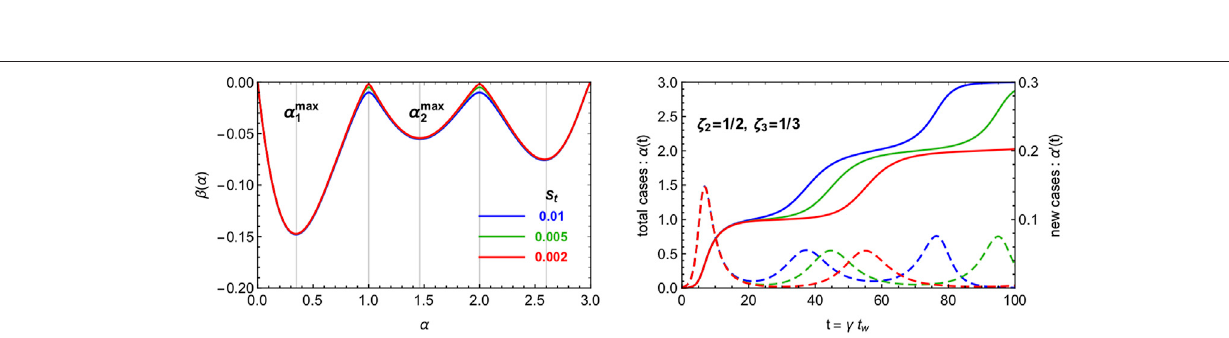
FIGURE3| Illustrationofthemulti-waveCeRGmodel,withtwowaves.Inpanel (A) ,weshowthebetafunctionforthreedifferentvaluesofthestrollingparameter S t (for p 1 (cid:2) 0 . 55, p 2 (cid:2) 0 . 65 and ζ 2 (cid:2) 0 . 5). In panel (B) we show the time between the two peaks as a function of the relative height of the second peak, encoded in ζ 2 . In panels (C) and (D) we show sample solutions for three values of the strolling parameter, where the two panels differ by the value of ζ 2 (for p 1 (cid:2) 0 . 55 and p 2 (cid:2) 0 . 65).